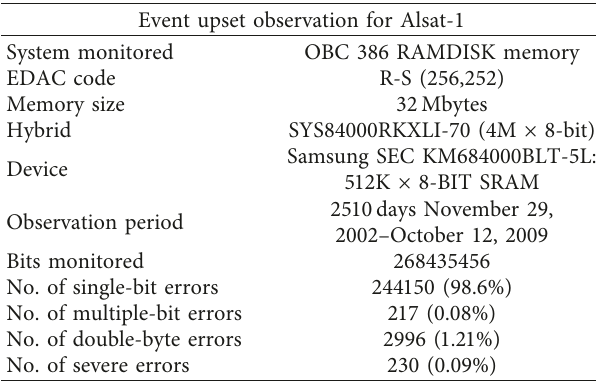
Table 3: Memory errors that observed on Alsat-1 during a 7-year period.